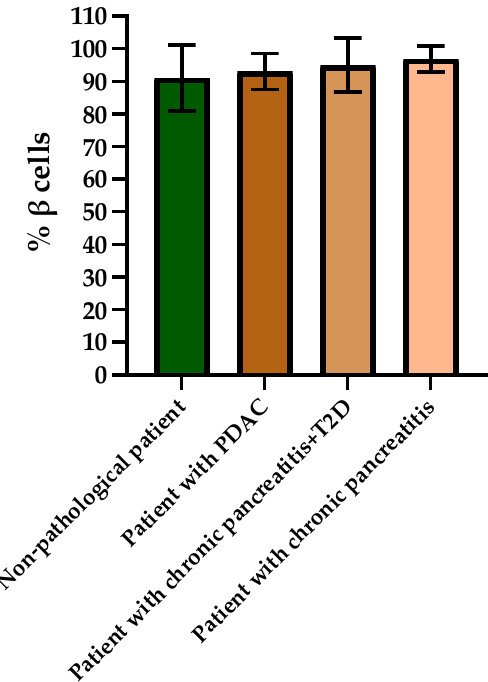
Figure 8. Histological (left) and immunohistochemical (right) analysis of the human pancreas. ( a ) nonpathological patient; ( b ) patient with PDAC; ( c ) patient with chronic pancreatitis + T2D and ( d ) patient with chronic pancreatitis.